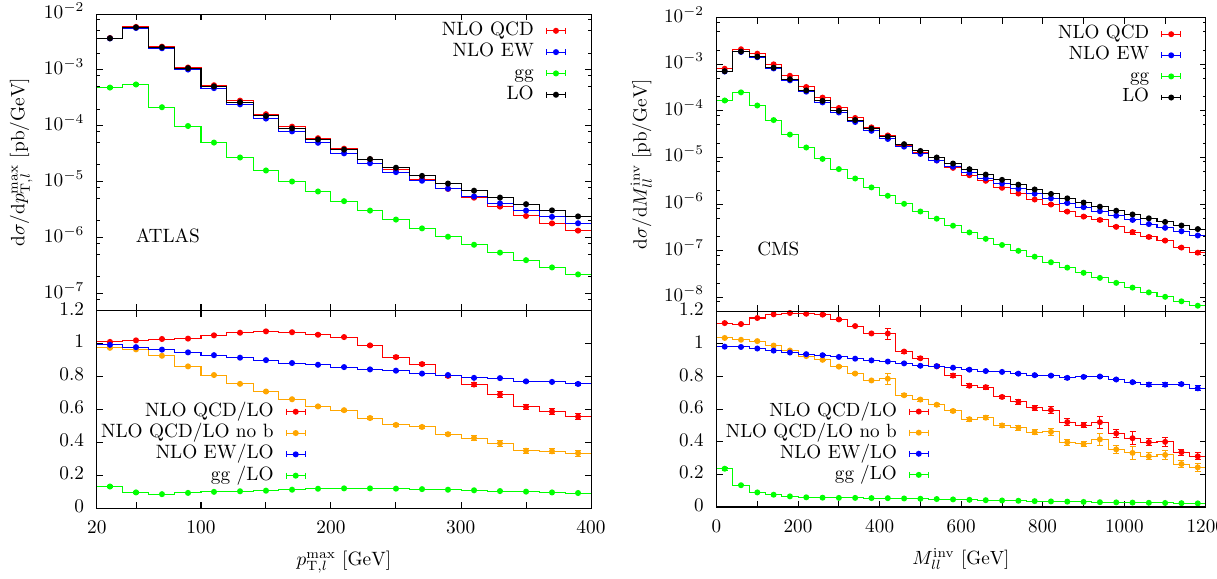
Fig. 4 Differential distribution in the transverse momentum of the hardest lepton ( p max √ s = 13TeV under the event selections of Eqs. (4.4) and (4.5). Same notations and conventions as in Fig. 2 for the process pp → e + ν e μ − ¯ ν μ at